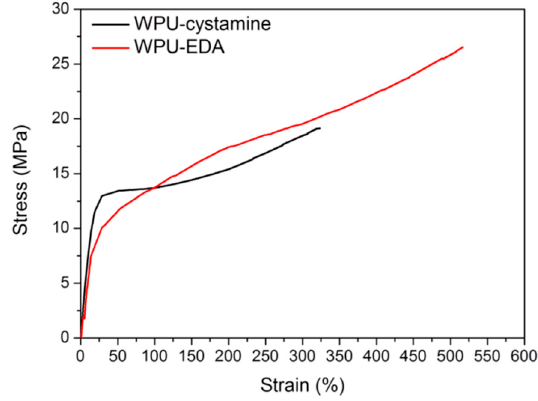
Figure 3. Mechanical properties of WPU-EDA and WPU-cystamine.